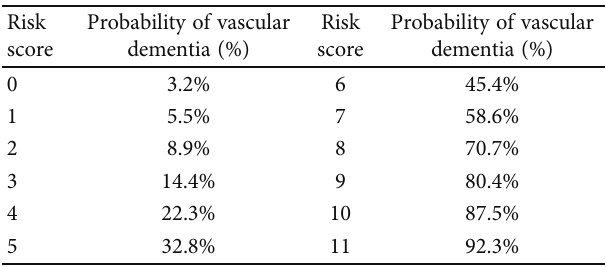
Table 5: Predicted probabilities of vascular dementia for each risk